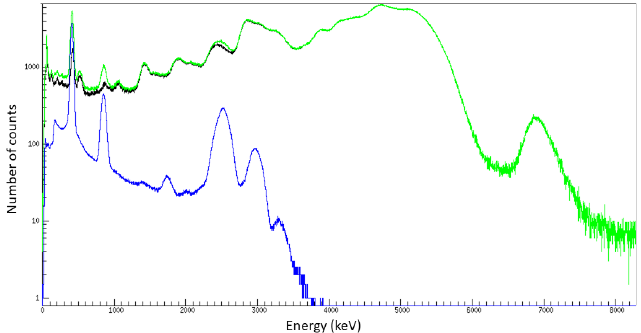
Figure 1. Experimental β gated MTAS total energy deposit spectrum for mass A = 87 (green), pure 87 Kr decay spectrum measured independently (blue), 87 Br β decay spectrum (black) obtained as a result of the spectra subtraction (green - blue). The 87 Kr spectrum was normalised on the 845 keV